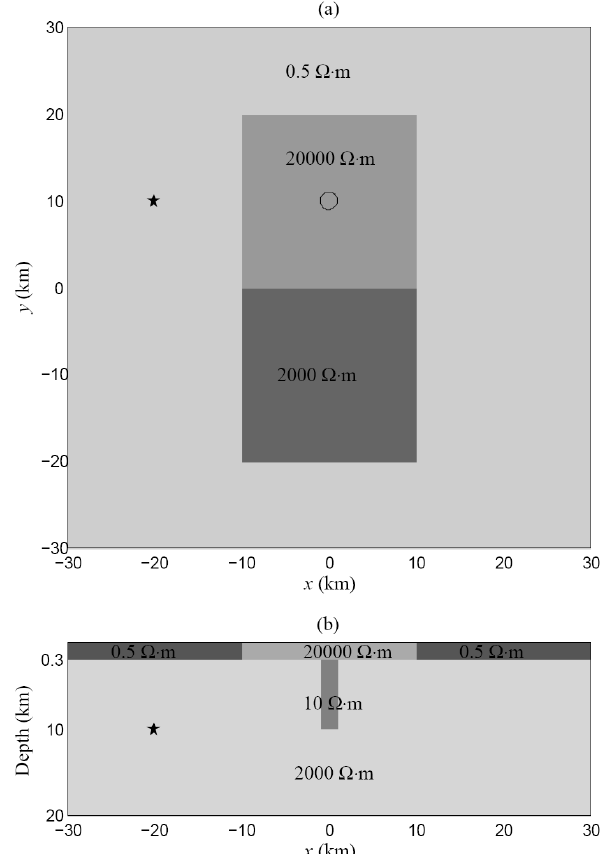
Fig. 3. A sketch model consists of ocean-land distribution, land resistivity inhomogeneity, and underground conductive channel (from Huang and Lin, 2010b). (a) Model distribution on the surface. The star and circle indicates the projection on the surface of the dipole current source and the underground conductive channel, respectively. (b) A cross-section including the dipole current source and the underground conductive channel.